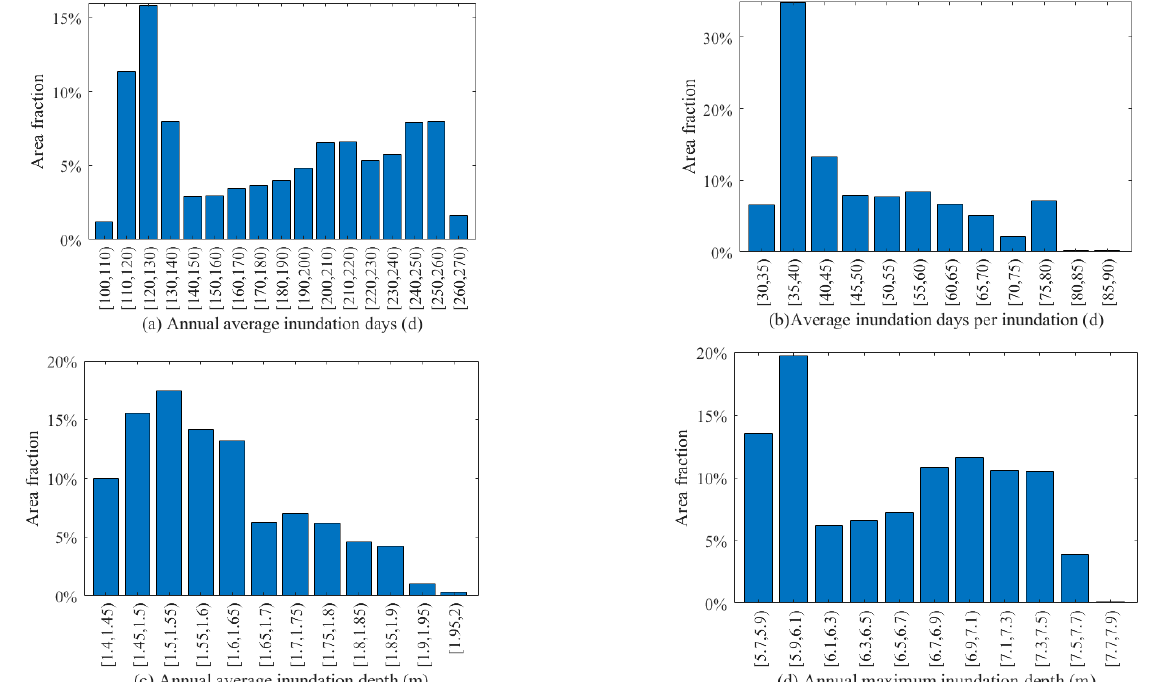
Figure 5. Area fraction of ( a ) annual average inundation days (d), ( b ) average inundation days per inundation (d), ( c ) annual average inundation depth (m), and ( d ) annual maximum inundation depth (m) in the study area.